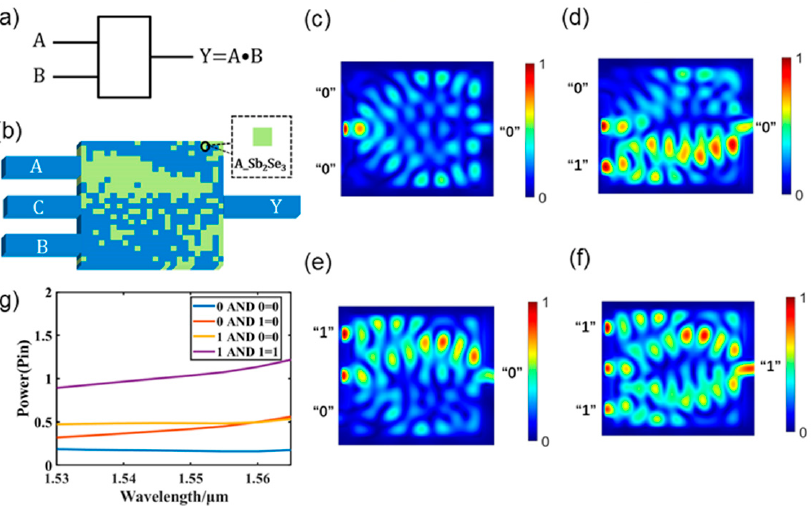
Figure 5. Photonic AND logic gate. ( a ) Graphical symbols of the AND logic gate; ( b ) designed AND logic gate; ( c – f ) light field intensity distributions of all operations of the AND logic gate; ( g ) output optical power diagram of the AND logic gate in the C-band. Table 5. Photonic AND logic gate power and binary output truth table data.